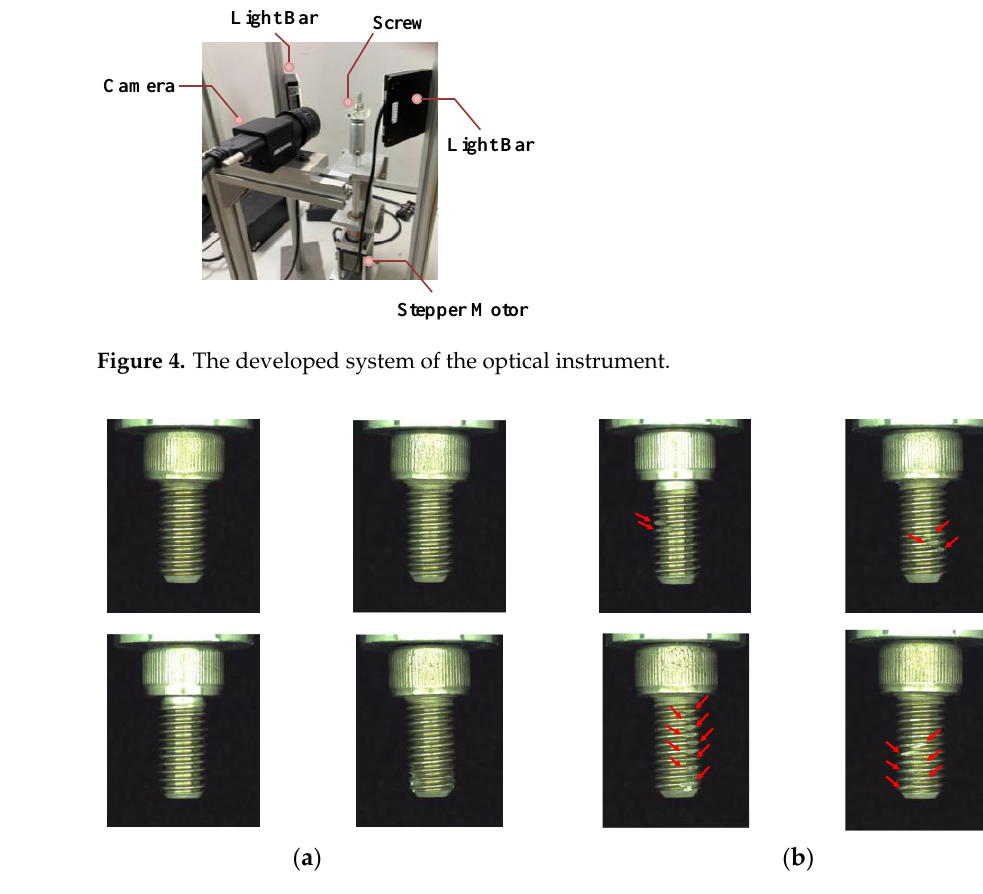
Figure 5. The experimental images of the spiral screw (unit: 0.03 mm/pixel). ( a ) Normal image; ( b ) defective image.